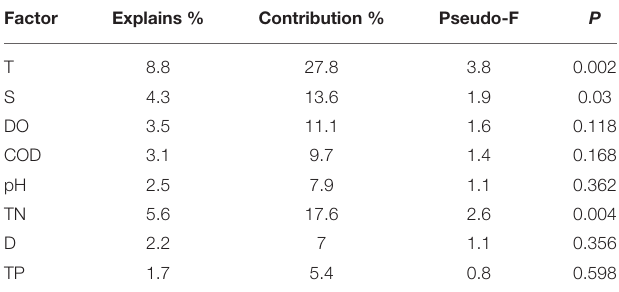
significantly positively correlated with biodensity and